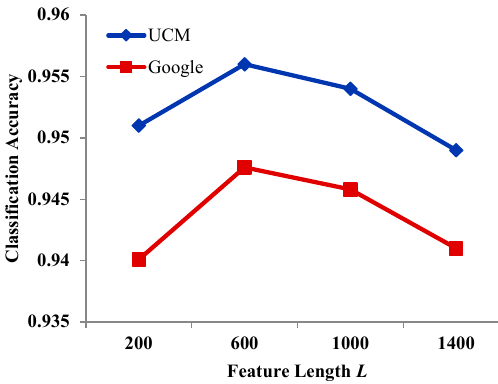
Figure 13. The relationship between feature length L and classification accuracy.